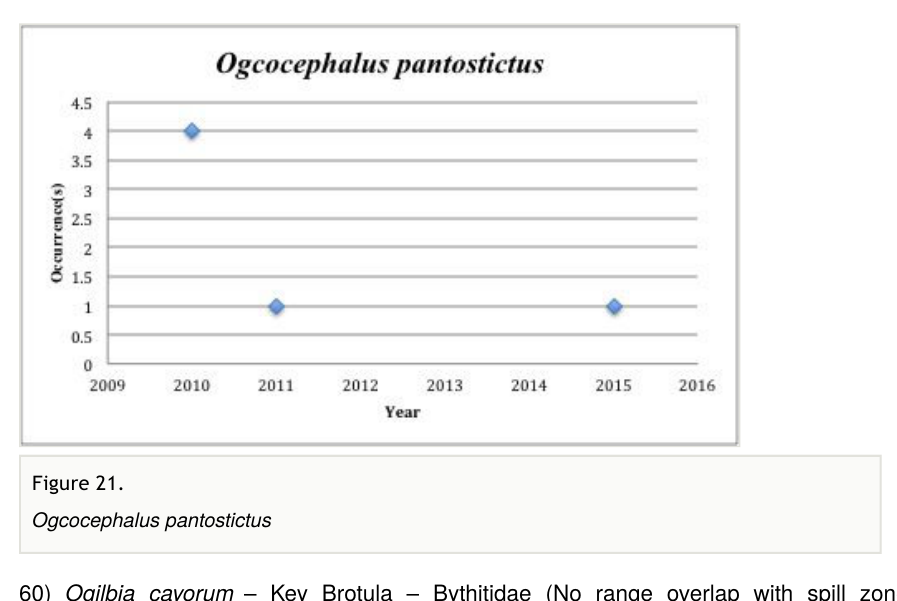
Figure 21. Ogcocephalus